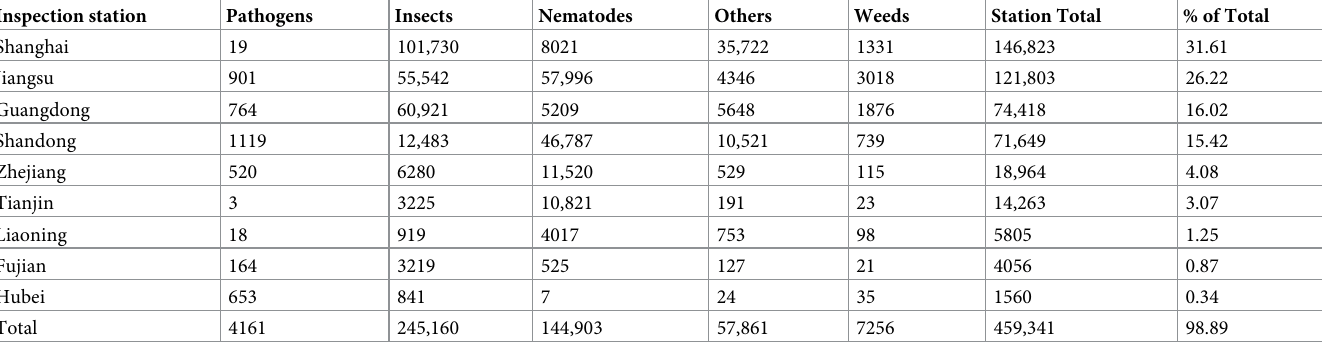
Table 2. The top nine provincial stations for WPM pest interceptions from 2003 to 2016 in China. Inspection station